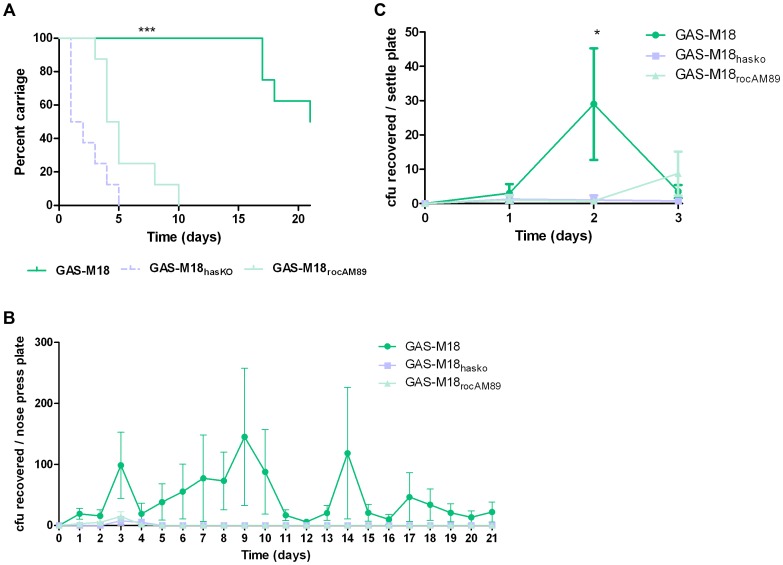
GAS-M18 nasopharyngeal carriage longevity and airborne spread require hyper-encapsulation induced by RocA truncation.(A) Quantification of murine nasopharyngeal carriage longevity of isogenic GAS strains GAS-M18, GAS-M18hasKO and GAS-M18rocAM89 by nose-pressing (n = 8/group). Data represent percentage of mice colonized with each strain for 21 days following intra-nasal challenge (LogRank; *** = p<0.001). (B) Quantification of bacterial shedding as mean number of GAS cfu recovered from the mouse nasopharynx by daily nose-pressing onto individual blood agar plates (AUC and Kruskal Wallis (p<0.05)). (C) Quantification of airborne transmission of GAS to settle plates during the first 3 days of infection (n = 4 plates/cage) (AUC and Kruskal-Wallis; * = p<0.05).